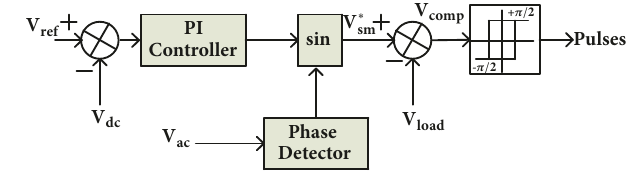
Figure 1: Control strategy of